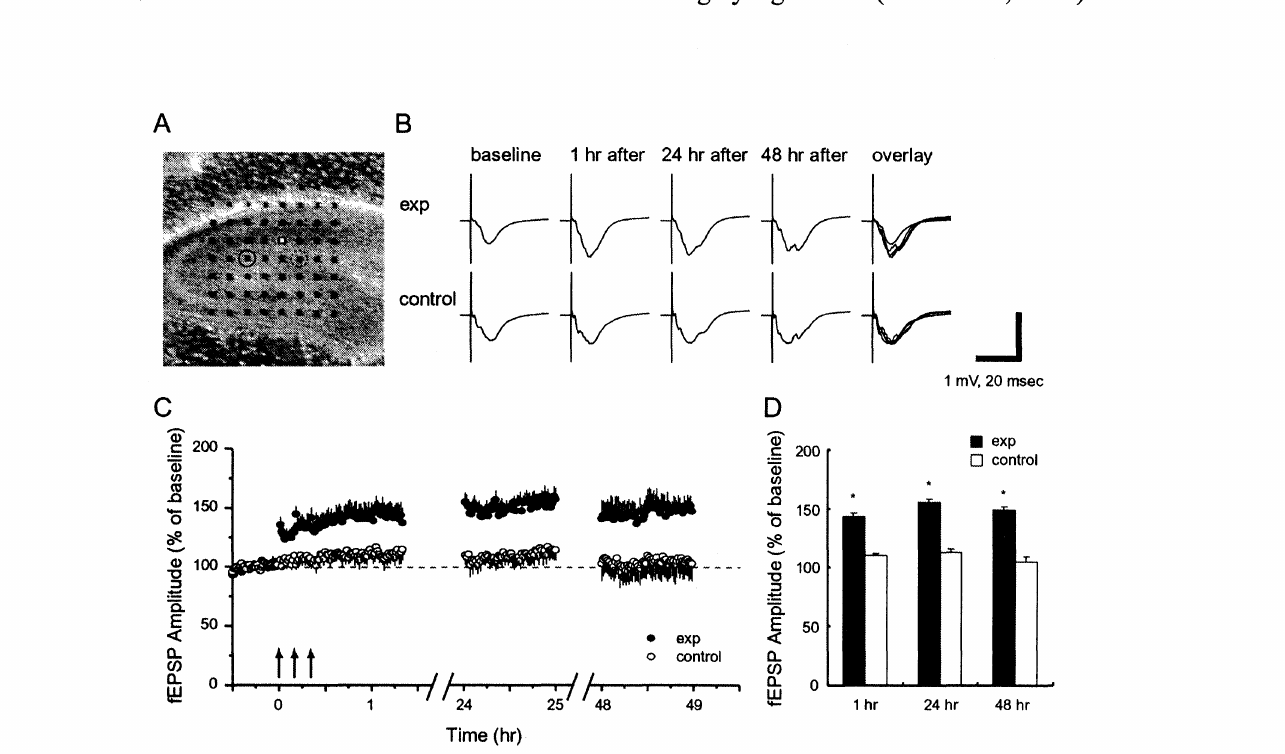
Fig. 1: Long lasting recording of long-term potentiation in cultured hippocampal slices. (A) Micrograph of a hippocampal slice cultured on an MED probe. Inter-electrode distance is 150 tm. The recording electrode is indicated by a white square, while stimulation electrodes are indicated by a solid circle (tetanized pathway (exp)) and a dotted circle (control pathway). (B) fEPSPs evoked by Schaffer fiber were recorded in field CA1 before and atter tetanus stimulation, fEPSPs evoked by stimulation of the tetanized pathway (exp) are shown on the top row and fEPSPs evoked by stimulation of the control pathway (control) are shown on the bottom row (each response is the average of 10 sweeps; typical examples are shown). (C) Summarized graph of long lasting LTP recording. The maximum amplitude of fEPSP was determined and calculated as percentage of averaged baseline values (means +/- S.E.M., n 8). Arrows indicate time of high frequency stimulation. (D) LTP amplitude was averaged over a 10 min period at h, 24 h and 48 h after high frequency stimulation, and was expressed as percentage of baseline